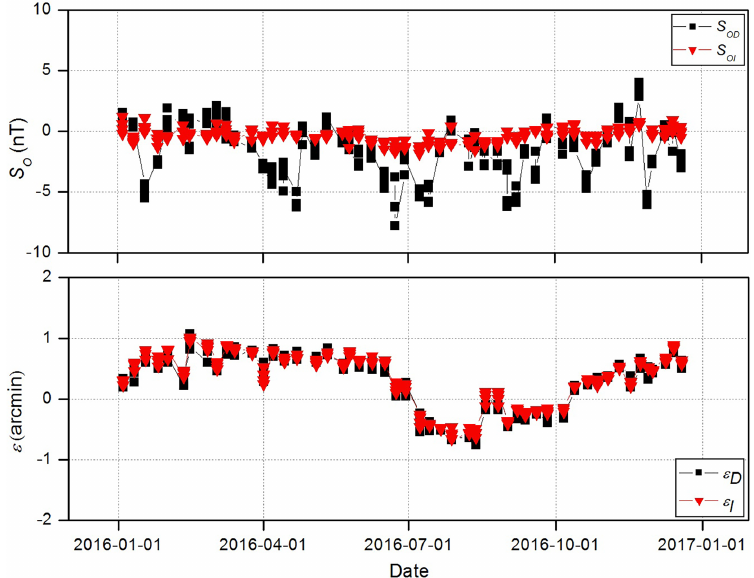
Figure 6. (Top) Sensor offset S O D for the declination and S O I for the inclination; (bottom) collimation angle ε D for the declination and ε I for the inclination.